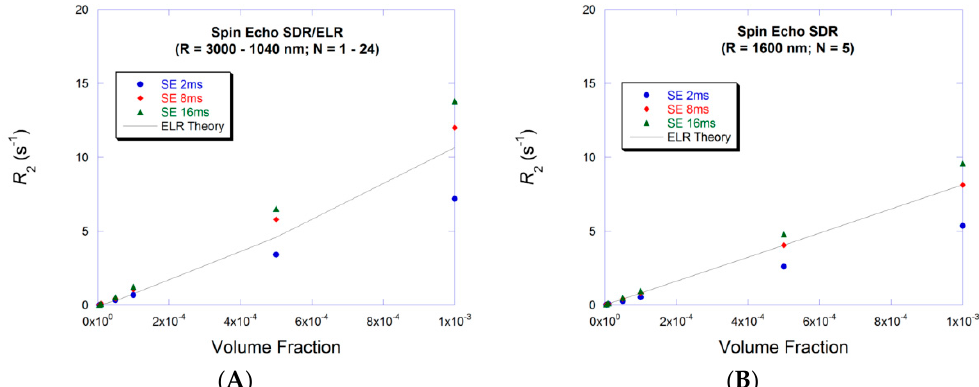
Figure 5. R 2 values are plotted vs. particle volume fraction for particles within MAR. ( A ) The particle size is increased while the radius is decreased to achieve increasing volume fraction; ( B ) The particle size and radius are kept constant while the sample space is decreased to achieve increasing volume fraction. ELR theory is shown for the echo-time (8 ms—red full circle) since data is now echo-time dependent. The data points represent averages of four measurements. Error bars representing the standard deviation were too small to show on the figures. For example, at volume fraction value 0.1, the standard deviation values were for the second particle arrangement (in ms − 1 ), respectively (i.e., Figures 5B and 6B), 3.9, 7.2 for TE = 2 ms; 75.0, 31.4 for TE = 8 ms; and 13.0, 25.0 for TE = 16 ms.